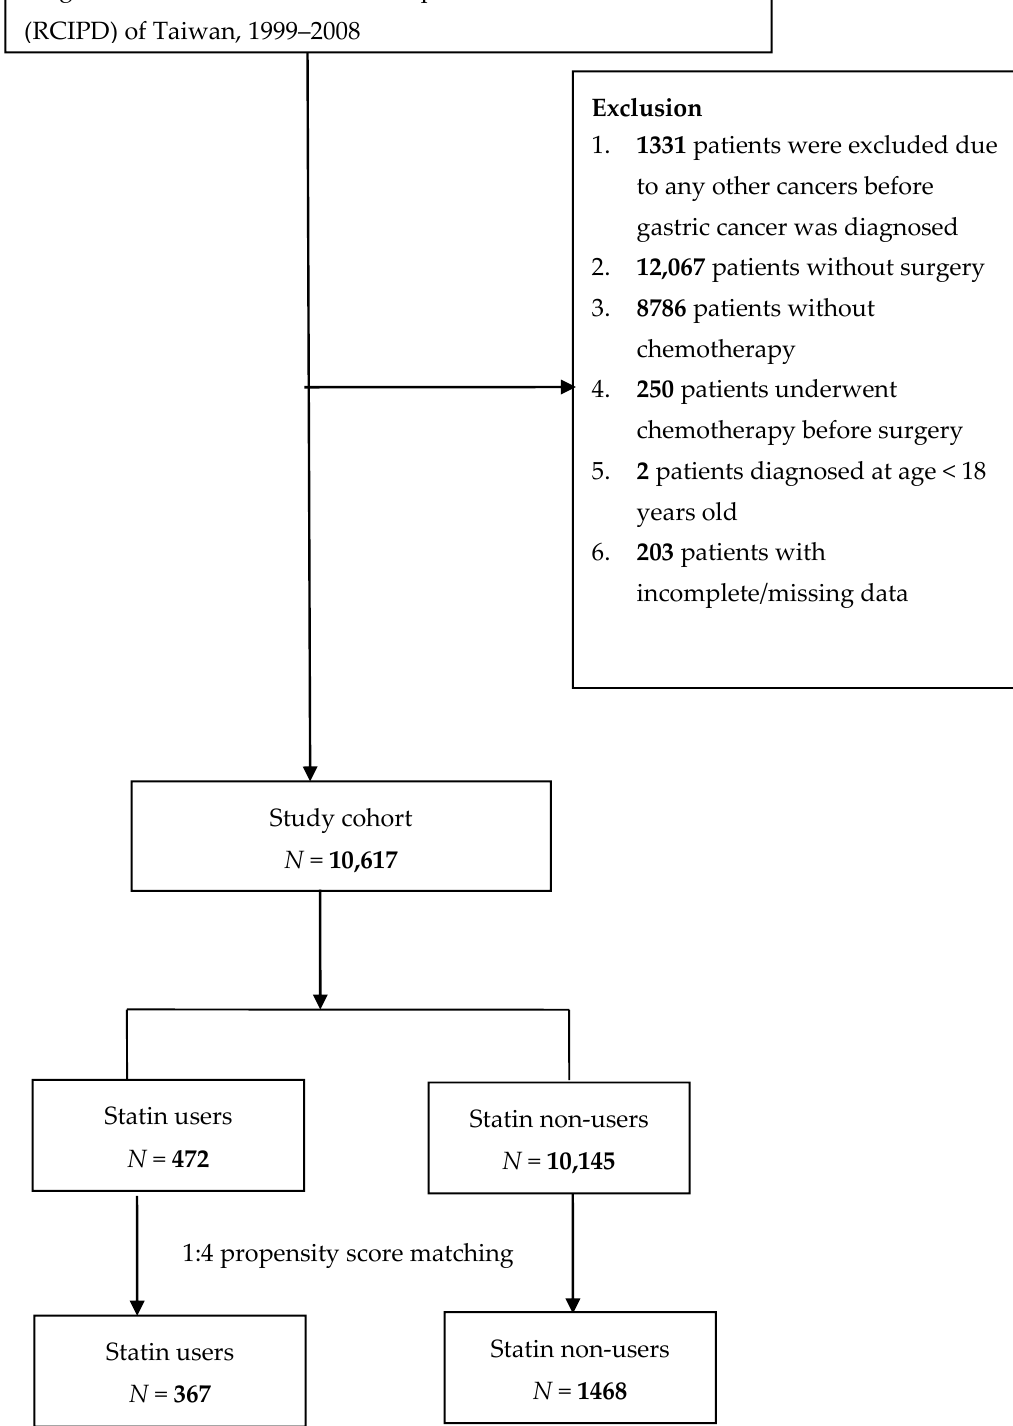
Figure 1. Flowchart of the patient enrollment process of the study cohort and matched cohort.